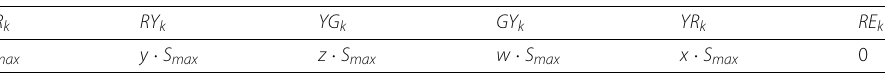
Table 1 The thresholds of KPI class from criteria A 1